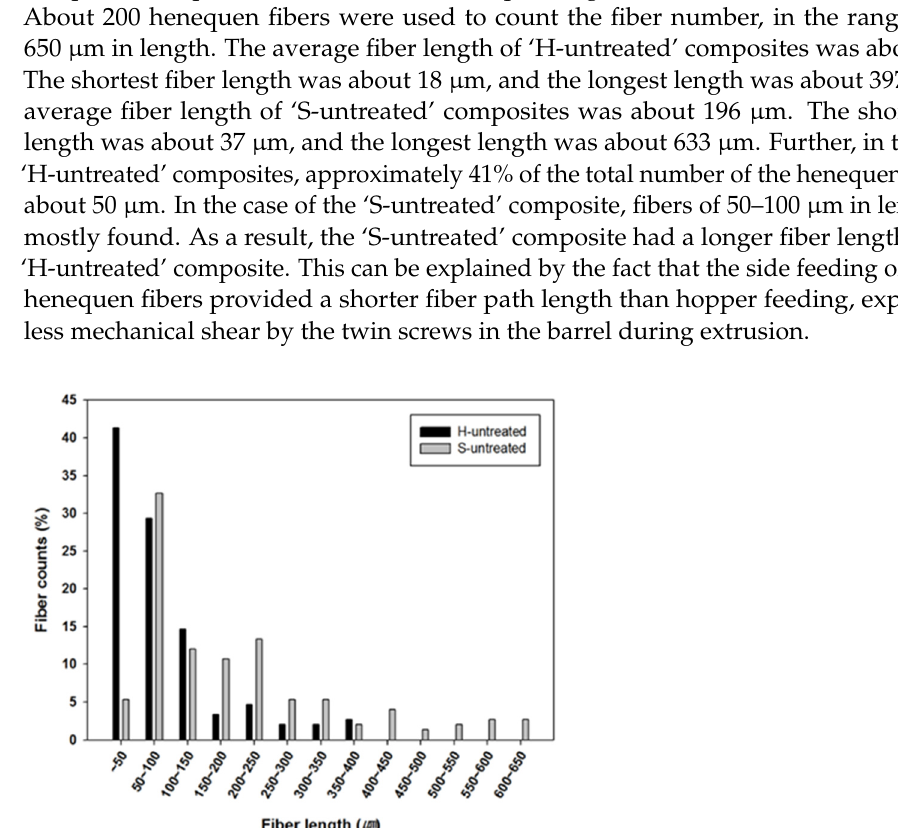
Figure 6. SEM images (×400) showing the henequen fiber surface topography ( A : untreated, B : alkali treated).